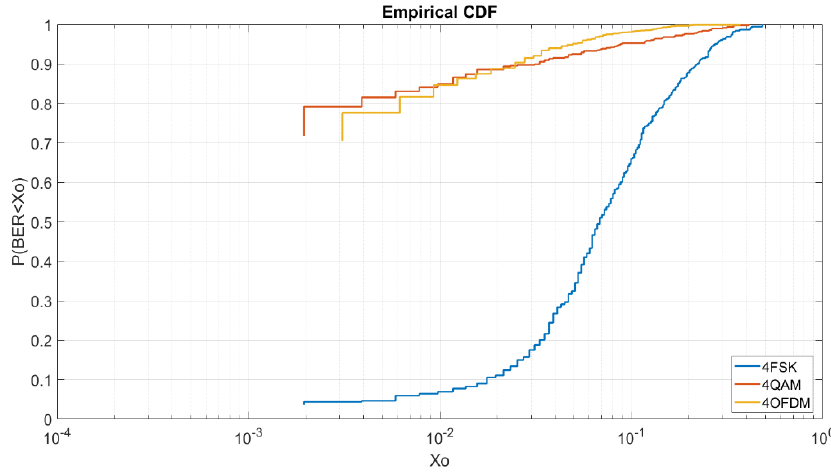
Figure 8. BER vs. E b / N 0 = 5 dB M = 4.